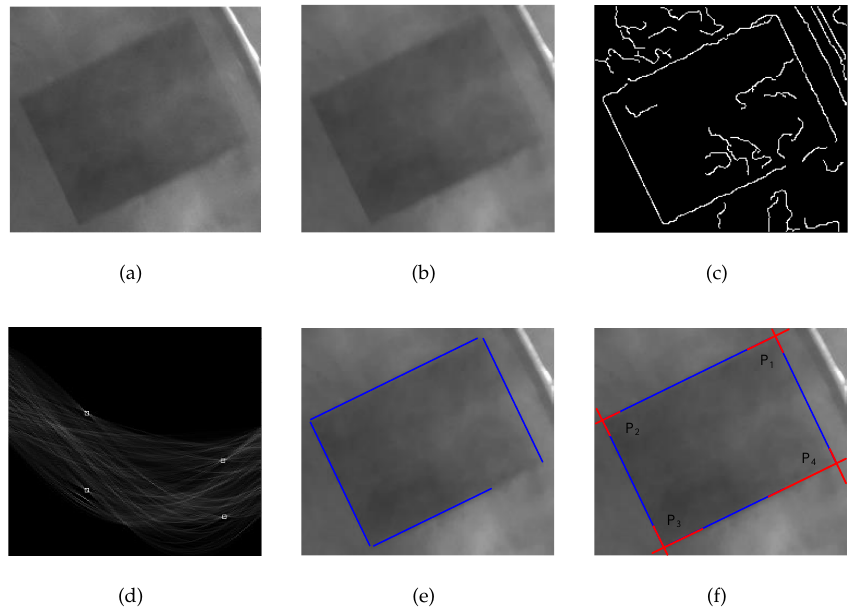
Figure 10. Processing of accurate handing hole location: ( a ) ROI, ( b ) denoised image, ( c ) result of counter detection, ( d ) parameter coordinate system, ( e ) raw line detection result, ( f ) result of corner